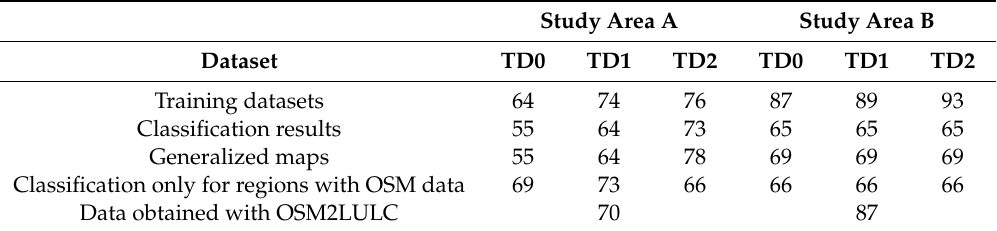
Table 8. Overall accuracy (%) of: the TD0, TD1 and TD2 training datasets; the maps resulting from the classification with the samples extracted from these datasets; their generalized versions; the classified maps considering only the regions where OSM data is available; and of the map generated using OSM2LULC software. The maps derived from COS 2018 with nomenclature harmonization were used as reference